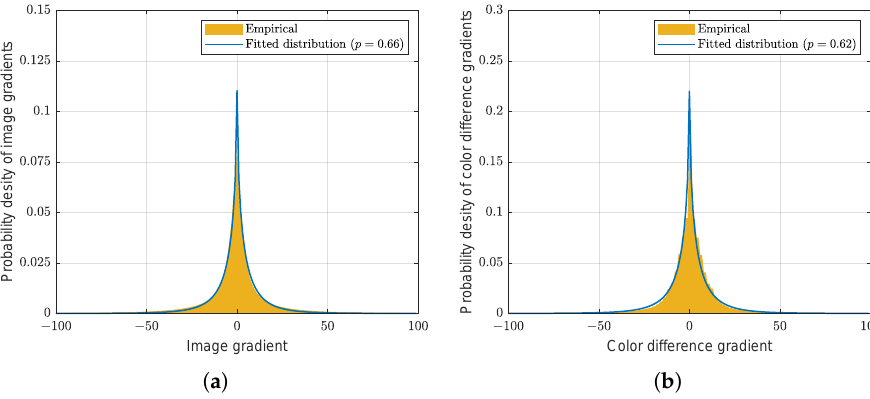
Figure 5. Probability distributions from Kodak and McMaster datasets: ( a ) Distribution of image gradients and ( b ) distribution of color difference gradients. The empirical distributions of im- age gradients and color difference gradients follow the probability distributions of p = 0.66 and 0.62,